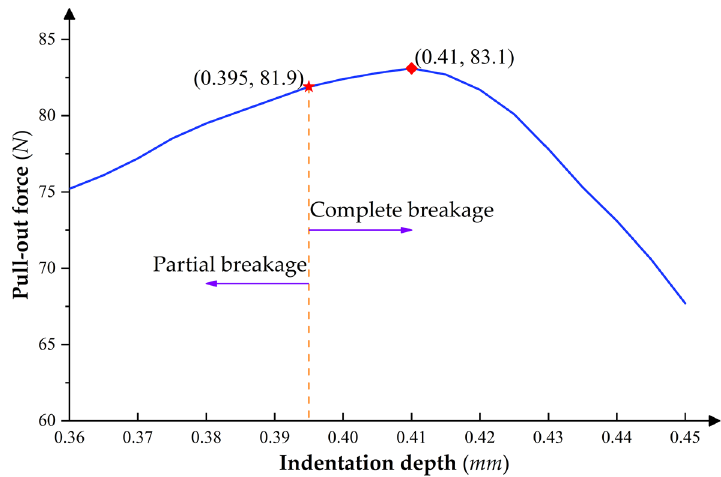
Figure 13. Variation of crimp terminal pull-out force and its failure mode with indentation